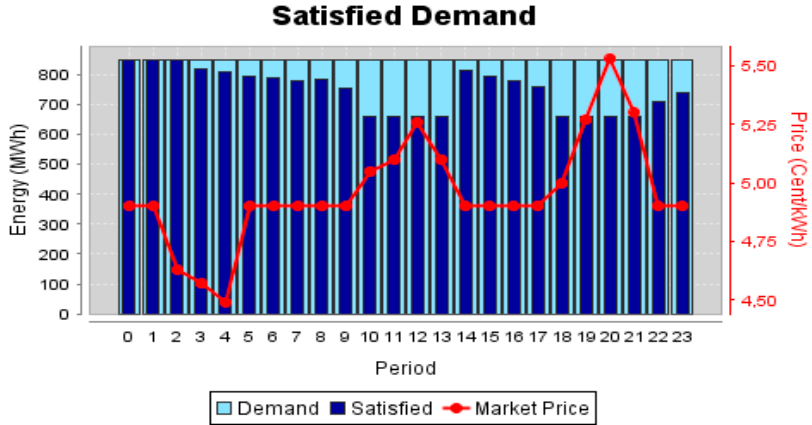
Figure 18. Satisfaction of the market demand in strategy 3.